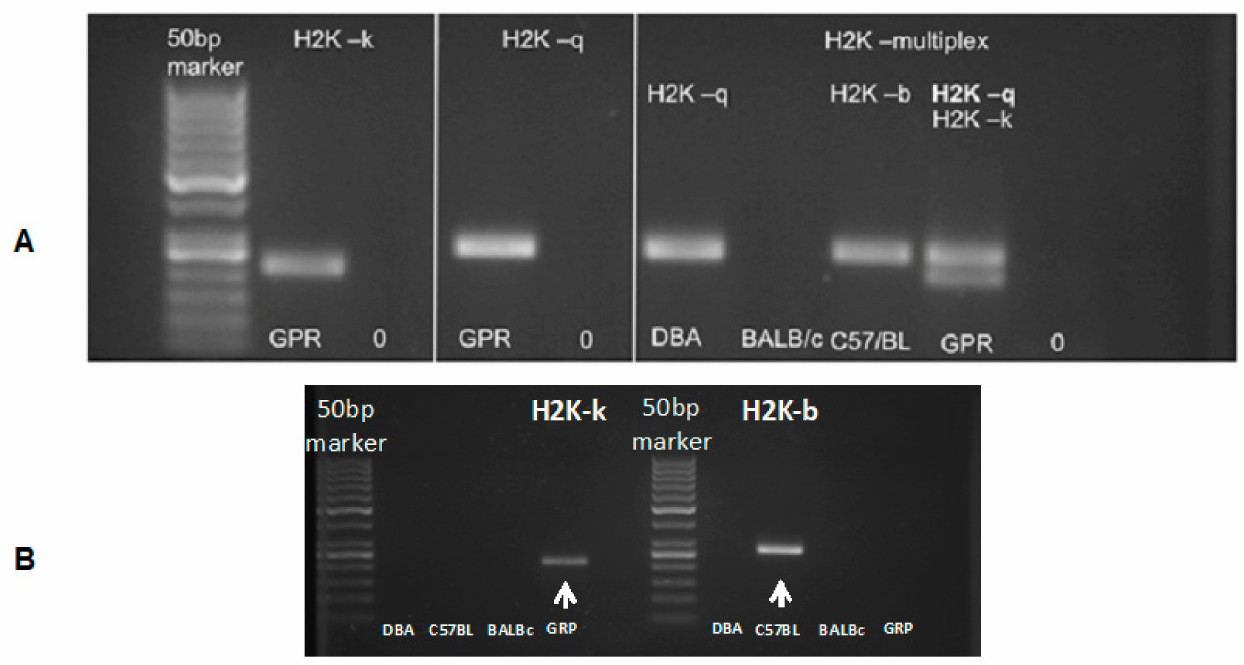
Figure 4. Murine GRP haplotype evaluation: ( A ) (in left panels) presents H2K-k and H2K-q typing results of the murine GRPs. ( A ) (in the right) presents the evaluation of the haplotype of DBA/1 mice (H2K-q), BALB/c (H2K-d), and C57BL/6 (H2K-b), as well as tested murine GRP cells, which gave positive results for both H2K-q and H2K-k haplotype. ( B ) (below) presents PCR results using only H2K-b specific primers to rule out the possibility of H2K-b expression, which is characterized with similar to H2K-k weight in the gel. Abbreviations: GRP-glial-restricted progenitor cell; PCR-polymerase chain